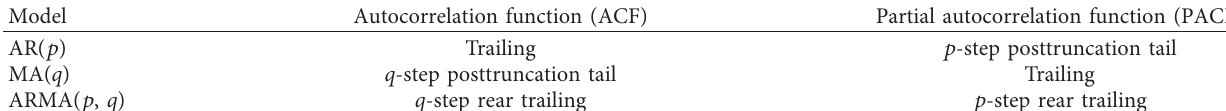
Figure 2: ARIMA modeling process. Table 1: Determination of model parameters p and q .